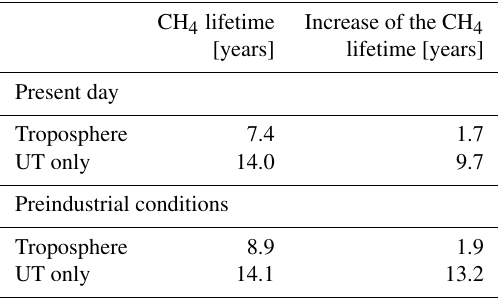
The CH 4 lifetime is calculated with the help of the actual methane and OH concentrations, calculating a pseudo-first-order loss rate. The corresponding temperature-dependent reaction rate is identical to the one used in the online chemistry calculations, also using the temperature output of the simulations. Calculating the lifetime for each individual cell, average values are determined using grid mass-weighted factors for certain regions or the whole